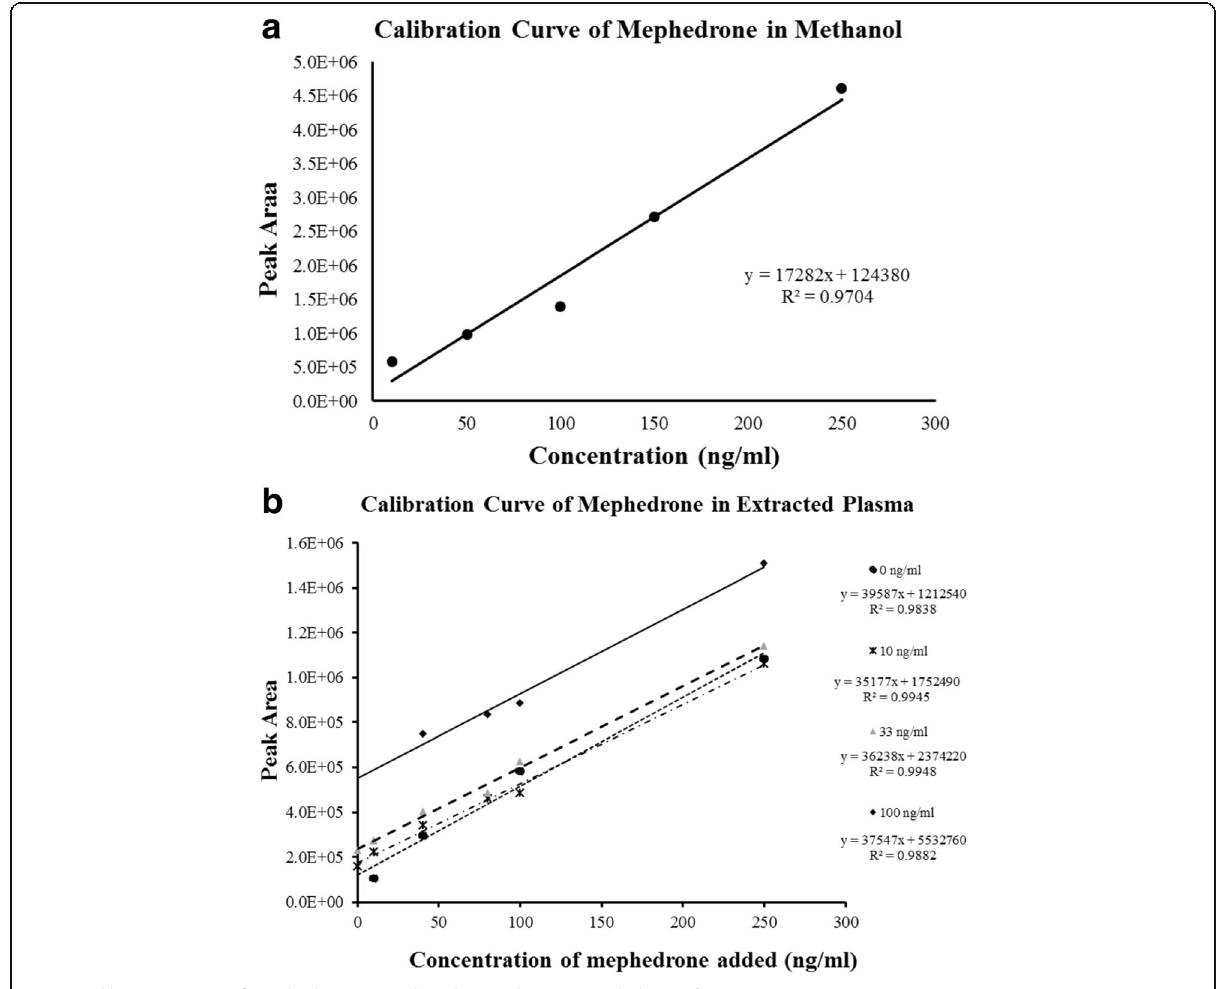
Fig. 3 Calibration curves of mephedrone in methanol ( a ) and in extracted plasma ( b )